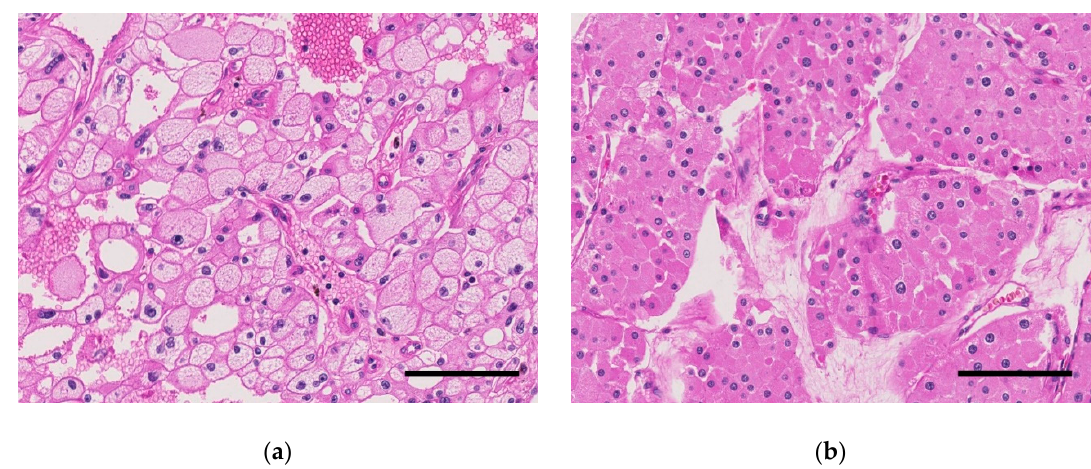
Figure 1. Representative microscopic images of chromophobe renal cell carcinomas (chRCCs) in the Swiss cohort (hematoxylin and eosin staining, scale bar, 100 µm). ( a ) classic chRCC with pale cells. ( b ) eosinophilic chRCC without pale cells. Table 1. Demographic and clinical characteristics.